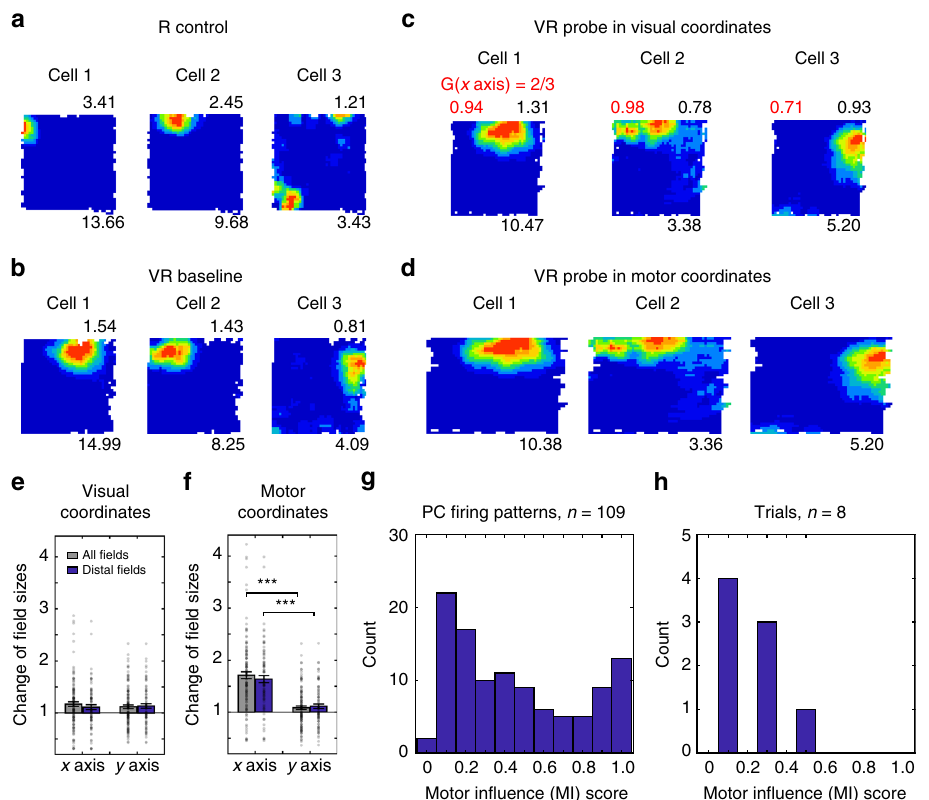
Fig. 2 Place cell fi ring patterns under visual gain decrease. a , b Three place cells simultaneously recorded in a 60 × 60 cm square box ( a ), a 60 × 60 cm virtual square ( b ), and a probe trial where visual gain was reduced along the x axis ( G = 2/3) plotted in motor coordinates ( c ) and visual coordinates ( d ). Layout as Fig. 1c – f, stretch factor F mapping visual plots to baseline shown in red. e , f Change of place fi eld size was signi fi cantly larger on the manipulated than un-manipulated axis when plottedi in motor coordinates ( f ; n = 122 for all fi elds, paired t -test, t (121) = 9.77, p < 0.001; n = 84 for fi elds distal to boundaries, t (83) = 7.71, p < 0.001) but not when plotted in visual coordinates ( e ; n = 122 for all fi elds, t (121) = 1.07, p = 0.29; n = 84 for distal fi elds, t (83) = − 0.45, p = 0.65), re fl ecting strong visual in fl uence. ( g , h ) Distribution of motor in fl uence scores ‘ MI ’ based on fi ring rate maps ( g ) or population vectors ( h ; see Methods and Fig.